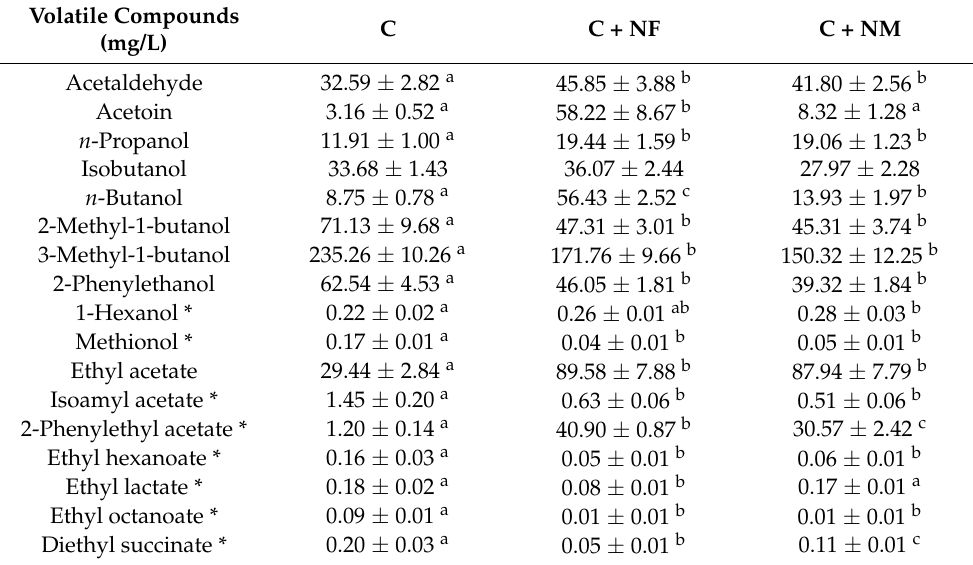
Table 2. Main volatile compounds content (mg/L) detected in wines obtained by the mixed starters with S. cerevisiae EC1118 (C) and H. osmophila ND1 in two different formulations (NF—free cells; NM—microencapsulated cells) in comparison with the single starter wine with EC1118 (C). For each compound, different superscript letters mean significant differences (Tukey’s test, p ≤ 0.05) among wines produced in the different conditions. Data are expressed as mean value ± SD of three independent experiments. * compounds identified by